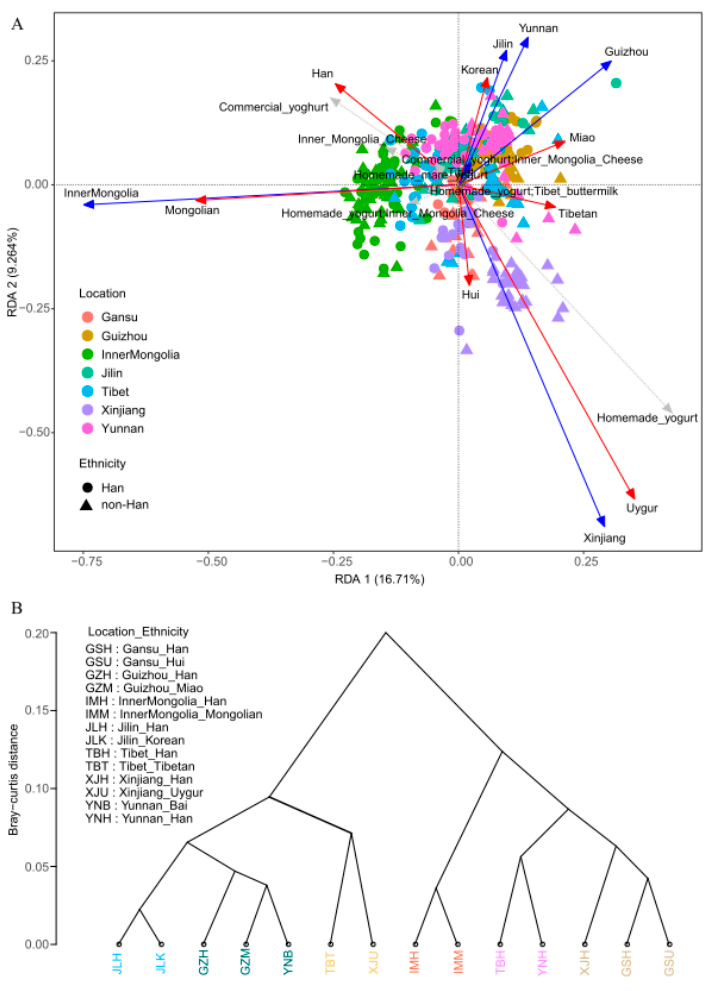
Figure 1. ( A ) Redundancy analysis (RDA) biplot (RDA on a covariance matrix, scaling 2) showing the two first axes of a canonical ordination of 394 samples. Circles and triangles represent different ethnicity [Han and other minorities (non_Han)] with 7 colors used to identify geographic location; only three factors (geographic location by using blue arrows, ethnicity by using red arrows and types_of_fermented_dairy_products by using grey arrows) were retained from 122 potential influencing variables after the forward selection. ( B ) Complete linkage agglomerative clustering dendrogram of Bray–Curtis distance of genera among different groups. The X -axis labels in different colors represent different groups.